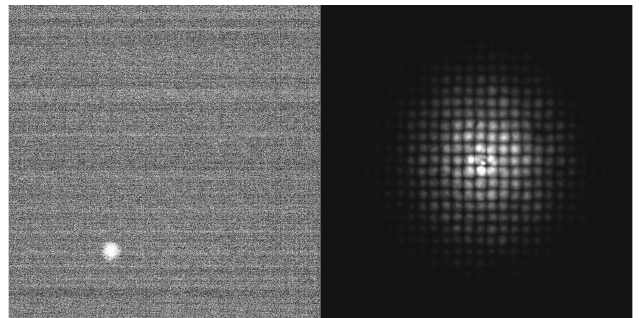
Figure 18 Pinhole scans for PC-246 at a beam energy of 8 keV. Image of a single pinhole position (left). Combined image of different pinhole positions (right).